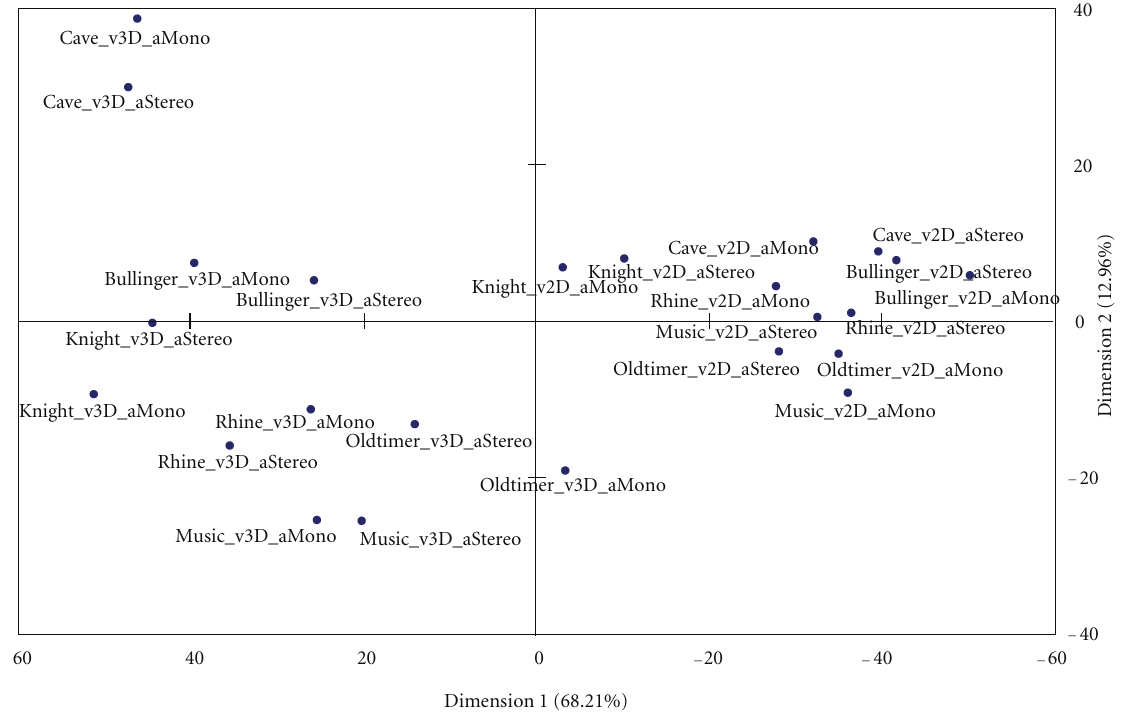
Figure 10: PCA scores of objects in the space of PC1 and PC2.